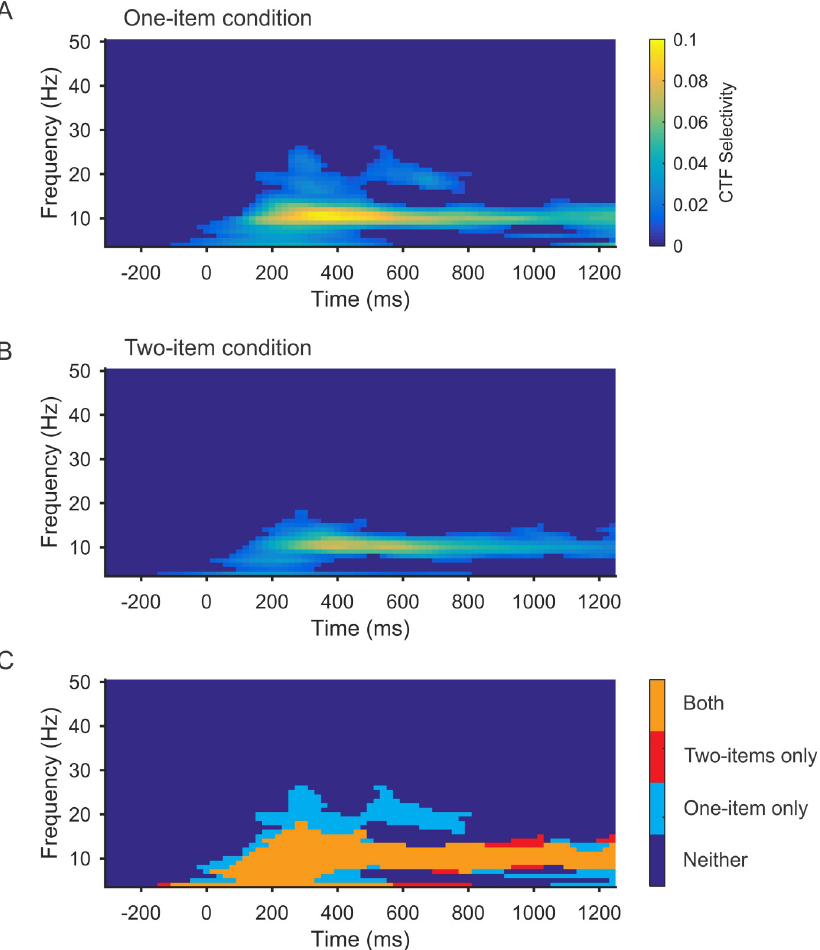
Fig 6. Identifying frequencies that track remembered positions during one-item and two-item maintenance. (A– B) Selectivity of spatial CTFs (measured as CTF slope) reconstructed from the scalp distribution of oscillatory power across a broad range of frequencies for the one-item (A) and two-item (B) conditions. Points with no reliable CTF selectivity as determined by the cluster-corrected permutation test are set to dark blue. (C) Overlay plot marking the clusters of reliable selectivity in the one-item condition (light blue), two-item condition (red), and both (orange). Data are available at https://osf.io/47cmn/. CTF, channel-tuning function.